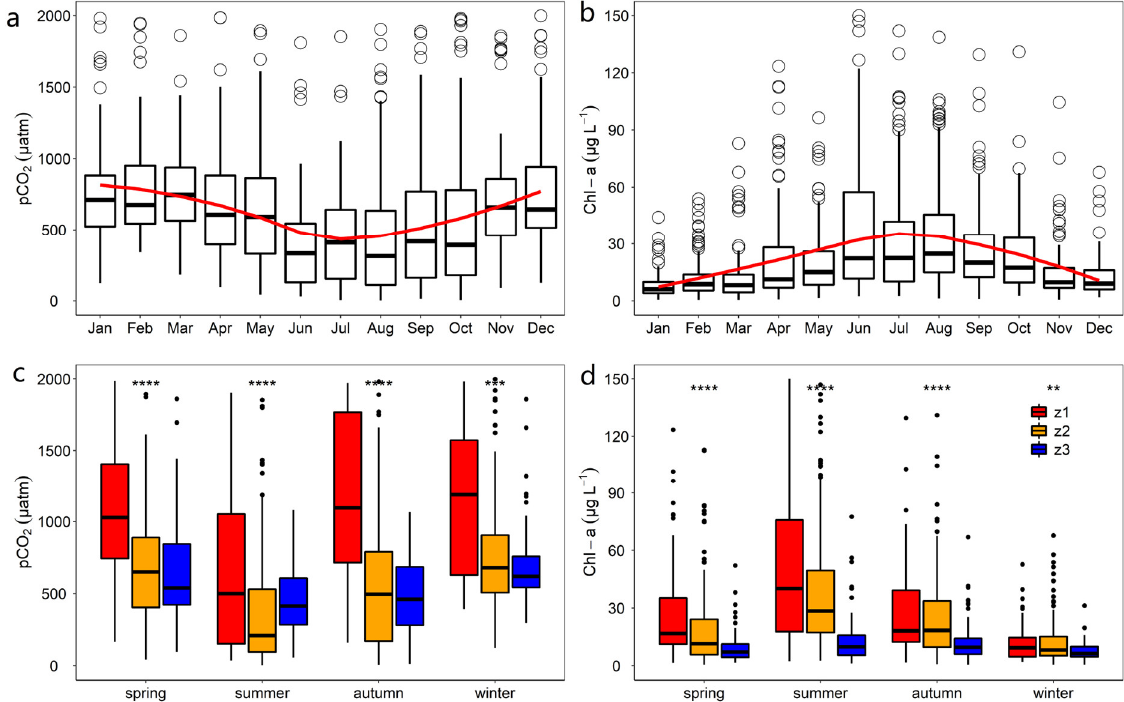
Figure 4. Monthly and seasonal patterns in pCO 2 ( a , c ) and Chl–a ( b , d ) concentration from 1992 to 2006. Smooth lines in red represent the trend based on the local polynomial regression (LOESS) procedure. The top and bottom of the boxes indicate the 75% and 25% confidence intervals, respectively; the horizontal line within the box is the median. **, ***, and **** indicate the difference is significant at the p < 0.01, p < 0.001 and p < 0.0001 level, respectively. The values of the 10th and 90th percentiles are represented by the upper and lower whiskers, respectively, while the dots indicate the value outside this range. Kruskal–Wallis test method was utilized to identify the seasonal differences of pCO 2 and Chl–a in different zones of Taihu Lake.